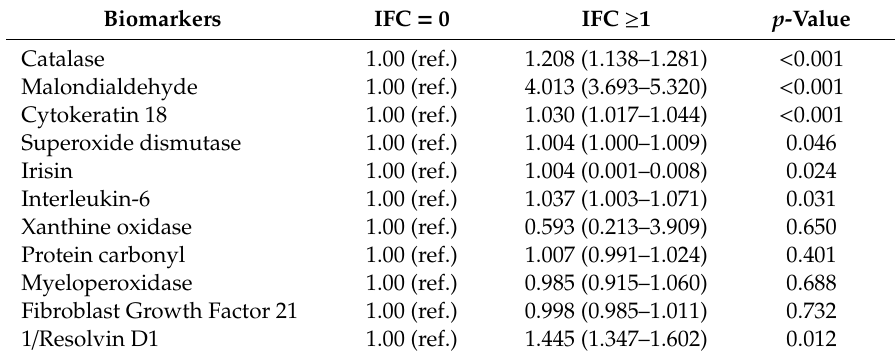
Table 3. Association of biomarkers and intrahepatic fat content